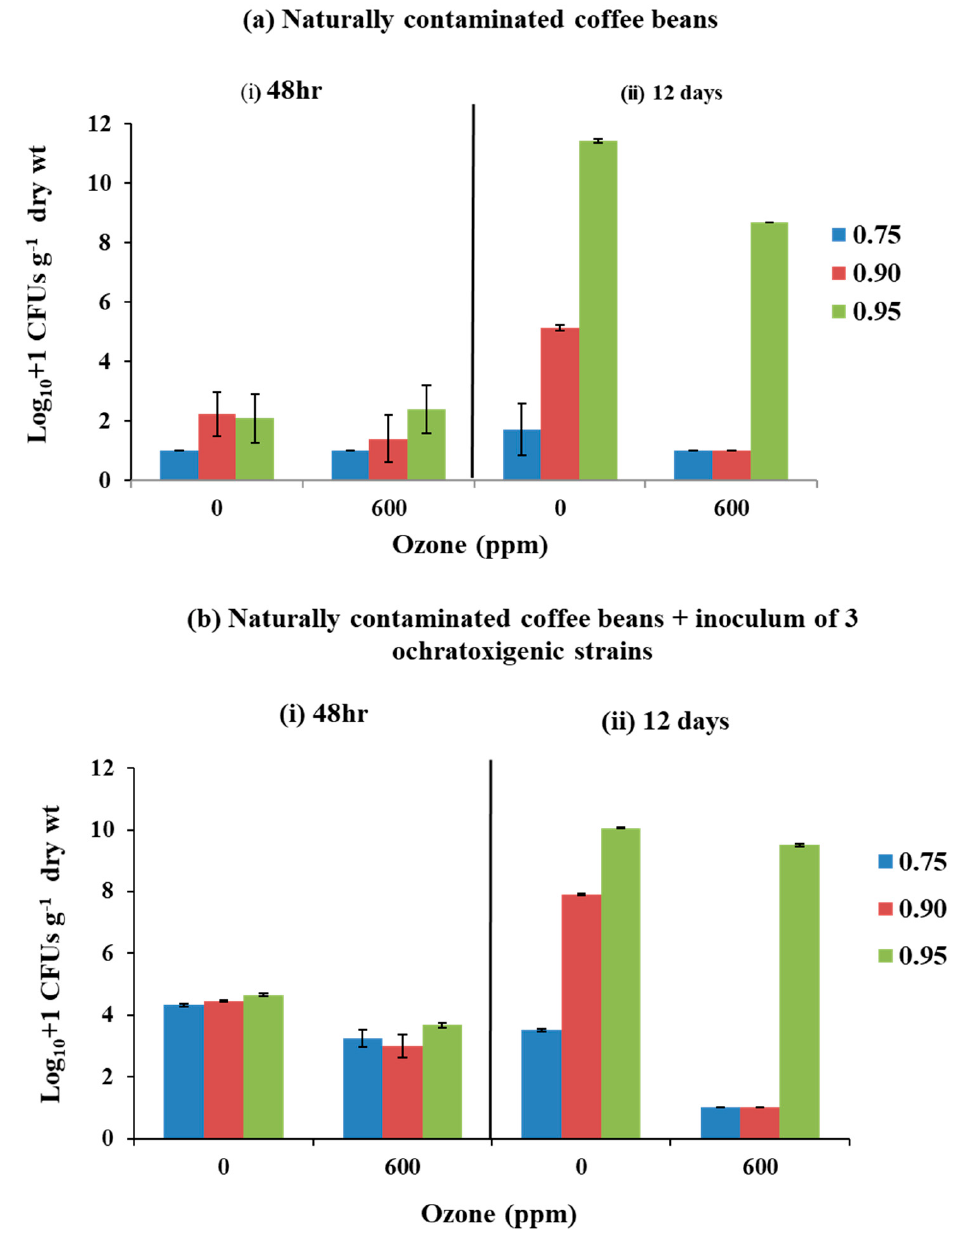
Figure 3. Effect of air or 600 ppm O 3 exposure for (600 ppm; 6 L min − 1 , 60 min) on the populations (log 10 +1 CFUs g − 1 dry weight) isolated from ( a ) naturally contaminated coffee beans and ( b ) naturally contaminated + inoculum of condia of A. westerdijkiae , A. ochraceus , and A. carbonarius in coffee beans adjusted to 0.75, 0.90, and 0.95 a w , compared to the controls (0 ppm O 3 ). (i) after exposure and (ii) 12 days storage at 30 °C. Vertical bars indicate the standard error of the means.